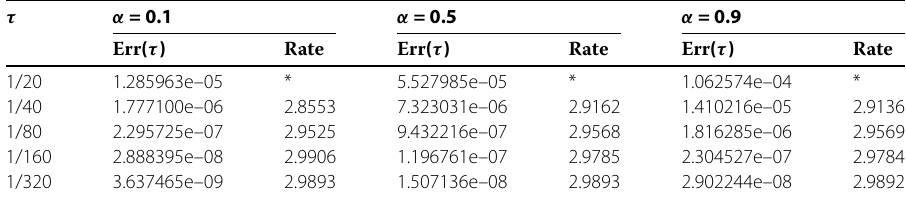
Table 3 Numerical errors and convergent orders with λ = 2, T = 1, when q = 3